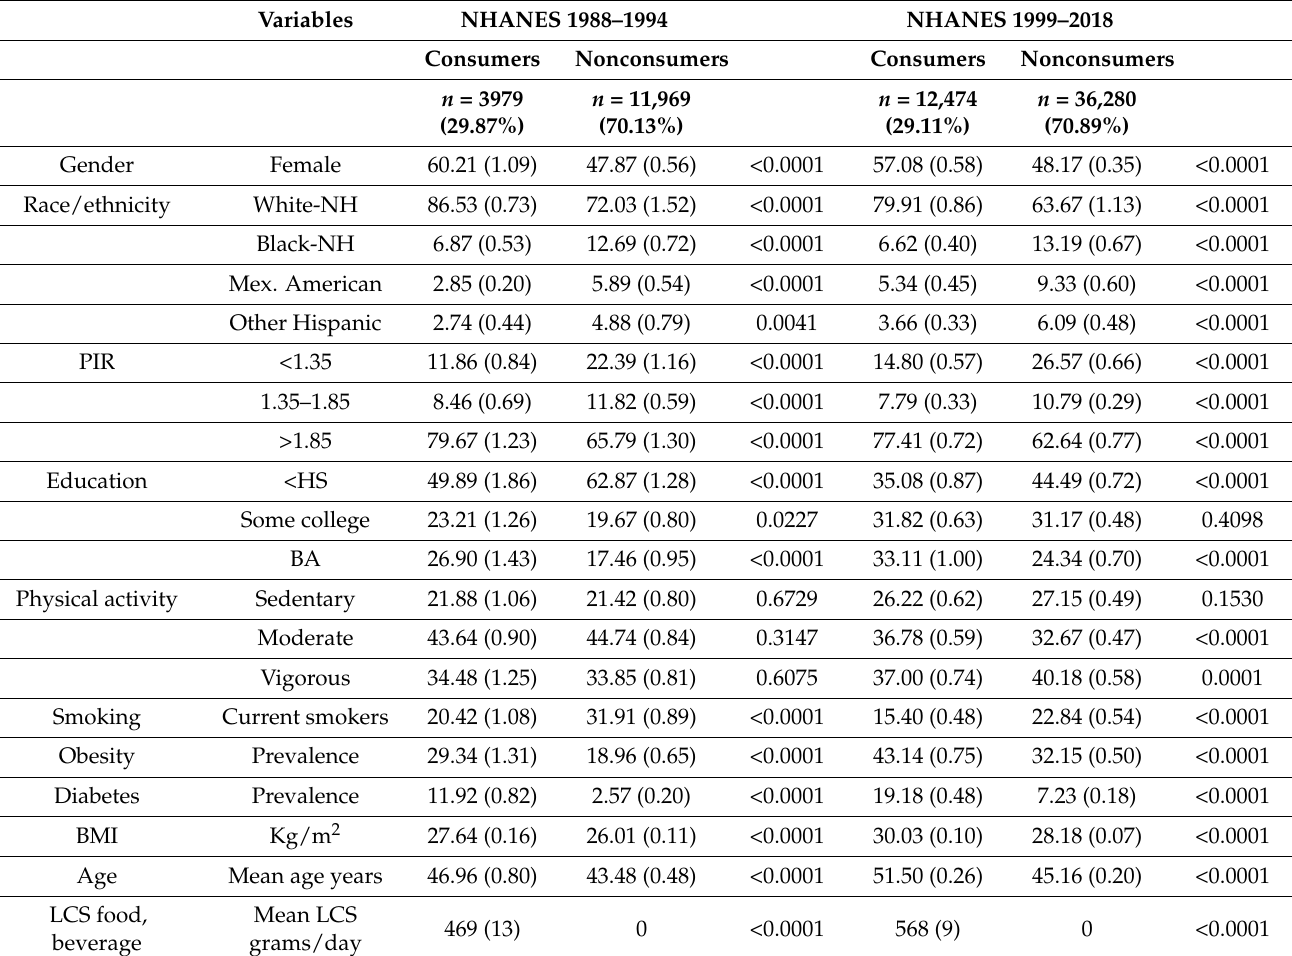
Table 3. Low calorie sweetener (LCS) consumers and nonconsumers by demographics and health outcomes. Data are percentages (standard error, SE) and means (SE). Data adjusted for complex sample design of NHANES using relevant sample